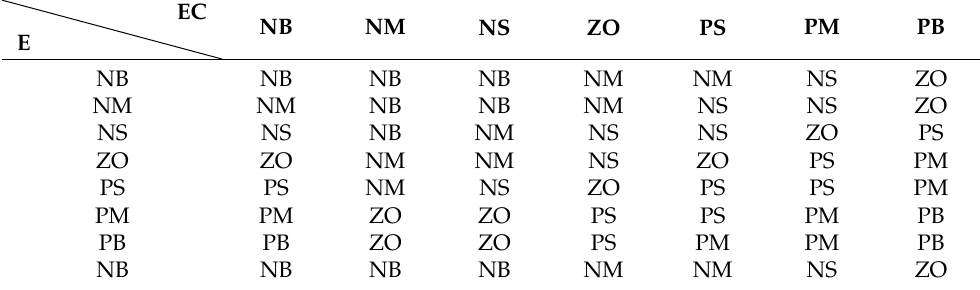
Table 2. Fuzzy rule of ∆ K i .